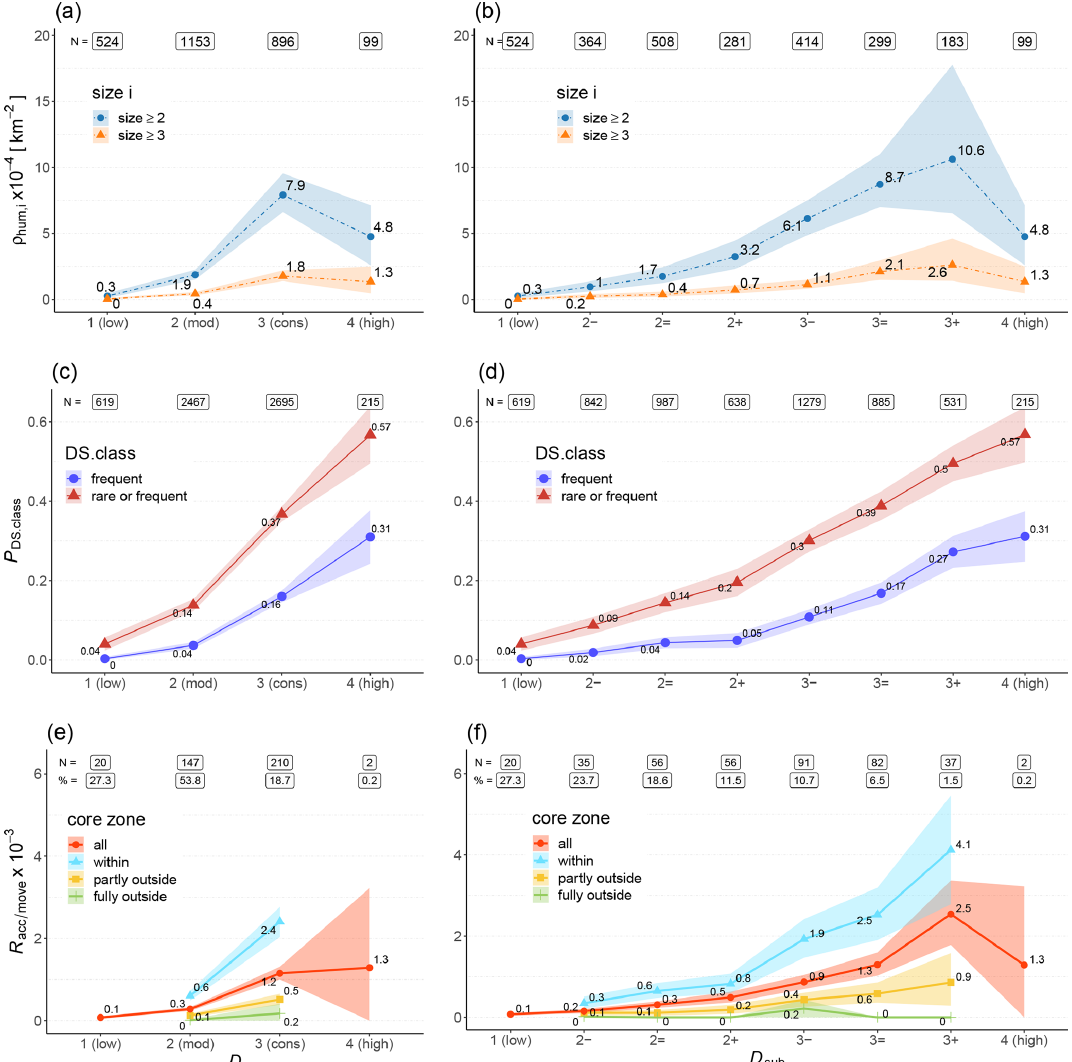
Figure 7. The density of human-triggered avalanches (or the number relative to the area of PRA) ( ρ hum , i ) (a, b) , the proportion of observa- tions with reported danger signs ( P DS . class ) (c, d) , and the ratio of accident to movement points during backcountry touring ( R acc / move ) (e, f) are compared to the danger level D (a, c, e) and sub-level D sub (b, d, f) . Shown are the median values (points) and the 95% confidence interval (shaded area). N represents the number of danger regions (a, b) , the number of observations (c, d) , and the number of accident points (e, f) . The number of movement points is expressed as percentage (%) relative to all movement points N =